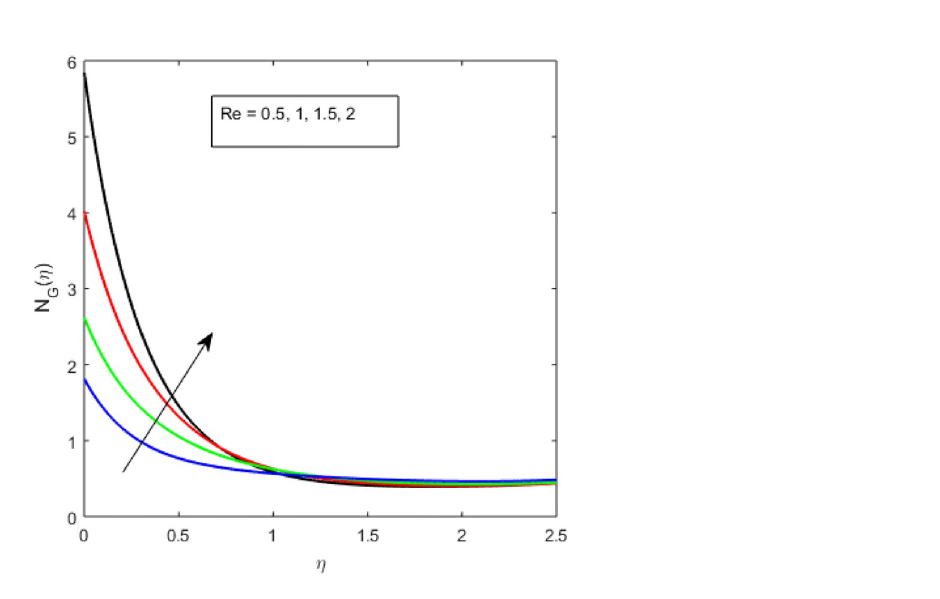
Figure 17. Entropy generation variation for increasing Re .